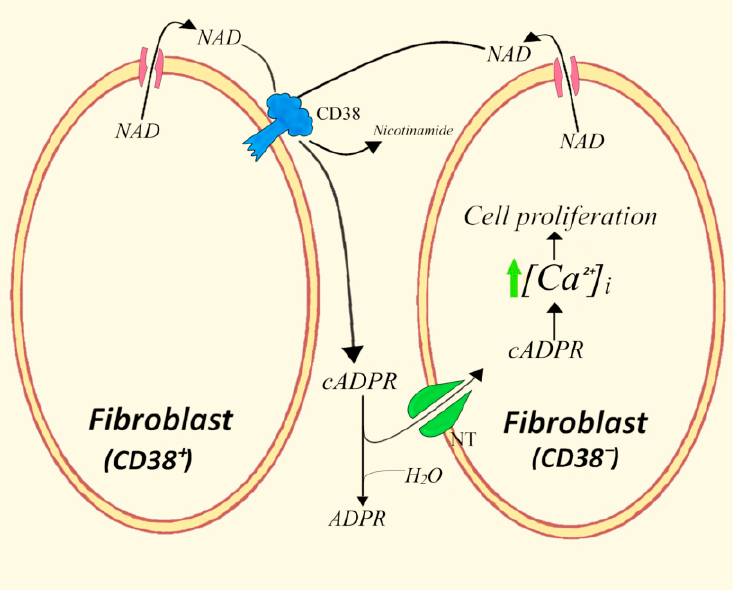
Figure 4. Uptake and effects of extracellularly generated cADPR by CD38 − 3T3 fibroblasts. NT, nucleoside transporter.